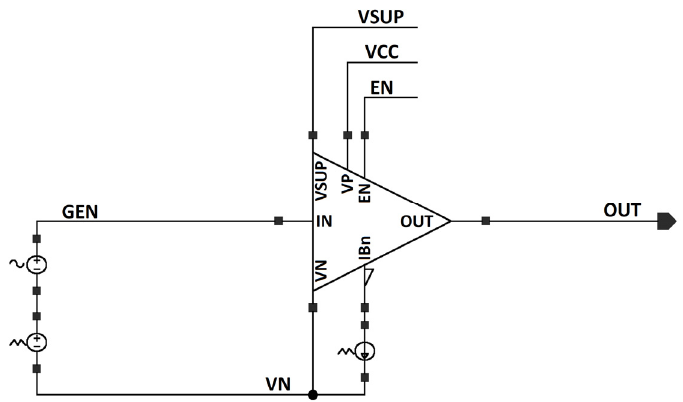
Figure 6. Simulation setup for the schematic-based buffer comparison.